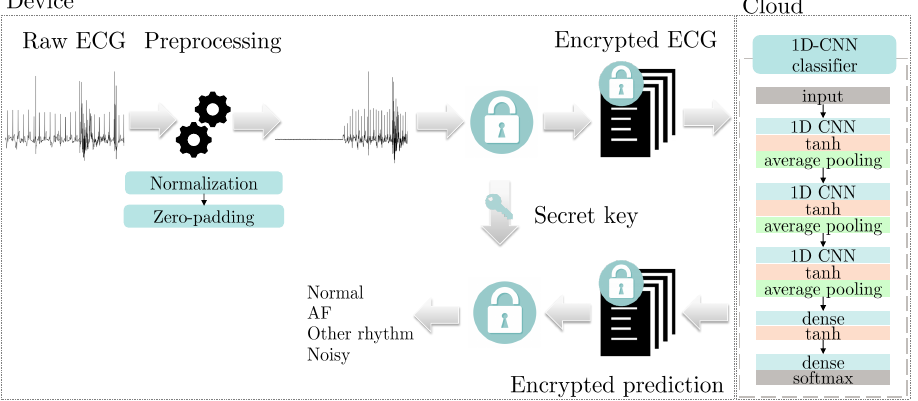
Figure 3. Workflow of the proposed privacy-preserving end-to-end ECG classification